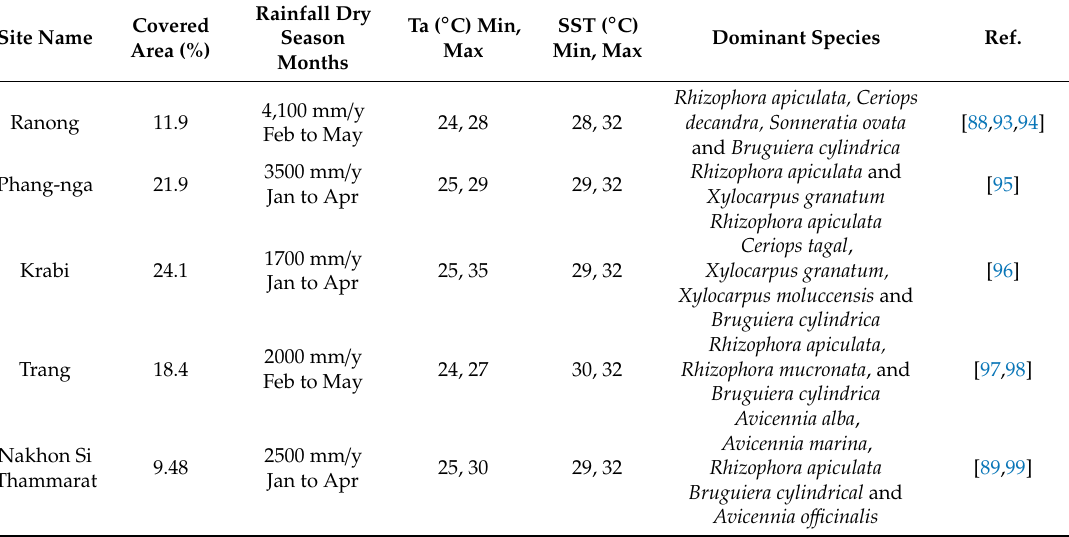
Table 1. Summary of the major characteristic of the study